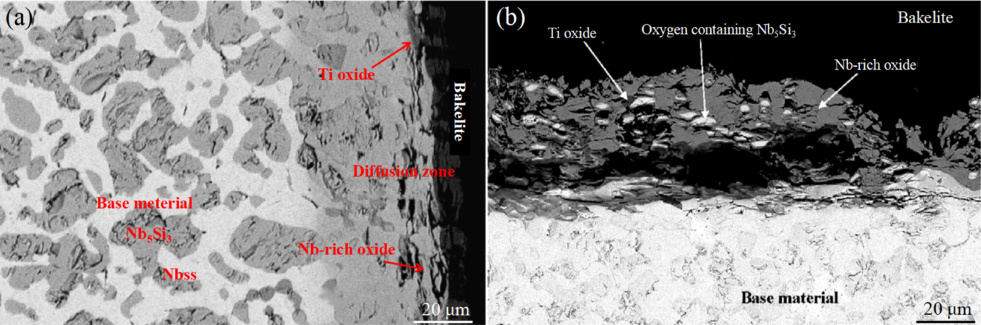
Figure 1. BSE images of the microstructures of cross-sections of the ( a ) Nb-24Ti-18Si-5Al-5Cr-2Mo and ( b ) Nb-24Ti-18Si-5Al- 5Cr-2Mo-5Hf after oxidation at 800 ◦ C. Copyright 2006 Elsevier.